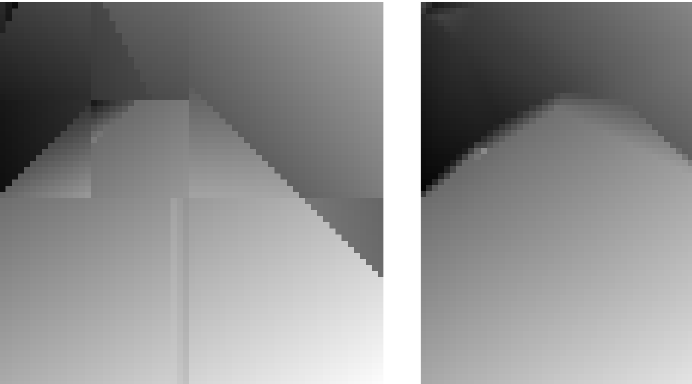
Figure 3. Estimators of the noisy images of Figure 2. ( Left ) piecewise linear wedgelet estimator; ( Right ) piecewise linear and continuous Delaunay